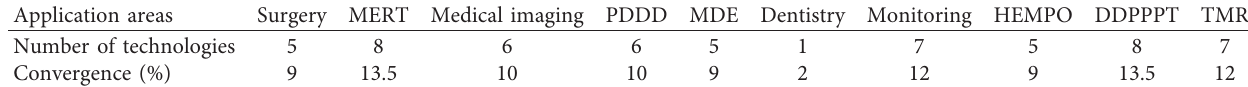
Table 9: Percentage convergence in healthcare application areas.